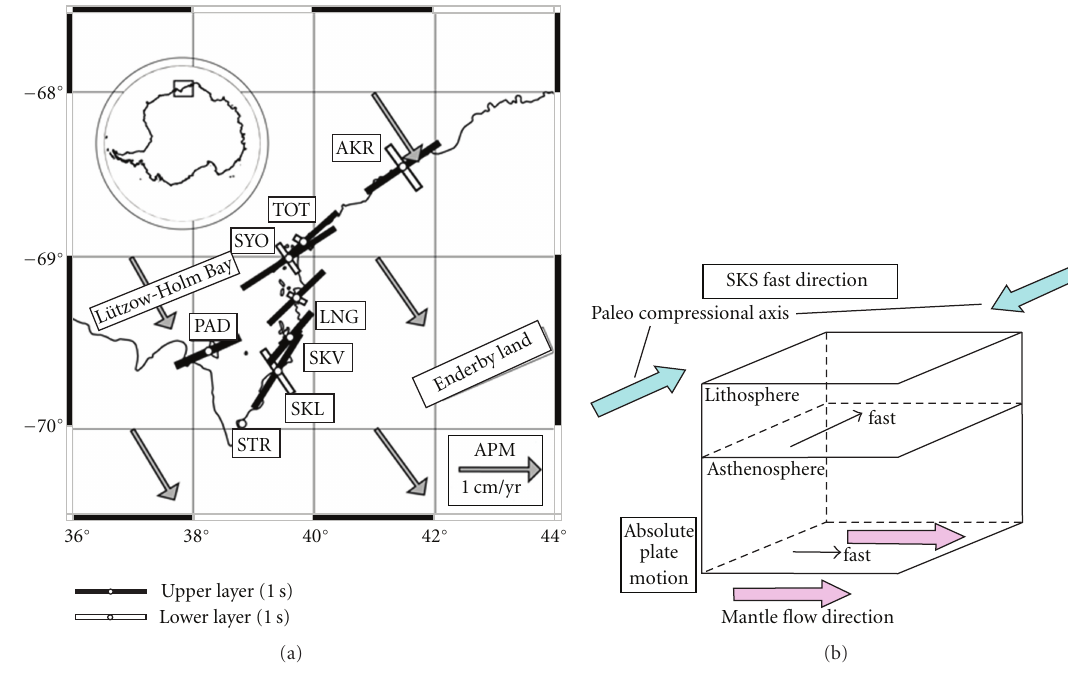
Figure 10: (a) Schematic illustration of the two-layered model for obtaining anisotropy. (b) Upper mantle anisotropy in LHB derived from SKS splitting (after Usui et al. 2007 [16]). At stations AKR, LNG, SKL, SYO, and TOT, the lower layer anisotropy was suspected to be caused by recent asthenospheric flow. For almost all other stations, the direction of the upper layer anisotropy (corresponds to the “lithosphere”) was parallel to NE-SW convergence during the Pan-African age.